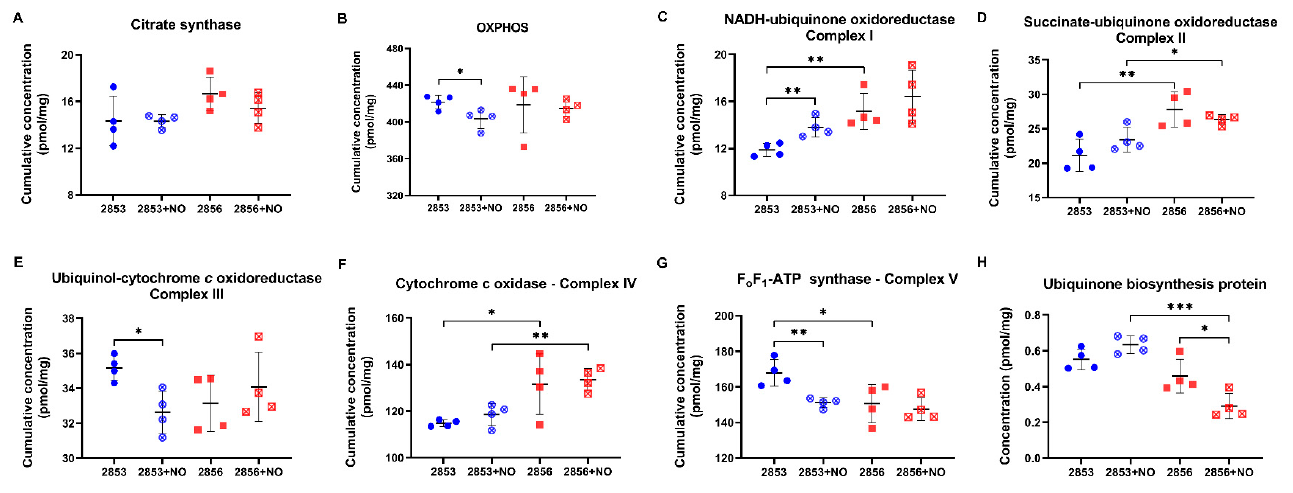
Figure 9. Proteins of mitochondrial oxidative phosphorylation (OXPHOS) are differentially modulated in L. braziliensis strains . ( A ) Cumulative concentration of all the identified proteins as citrate synthase. Cumulative concentration of all the identified proteins involved in ( B ) OXPHOS; ( C ) NADH-ubiquinone oxidoreductase (complex I); ( D ) succinate ubiquinone oxidoreductase (complex II); ( E ) ubiquinol:cytochrome c oxidoreductase (complex III); ( F ) cytochrome c oxidase (complex IV); and ( G ) F o F 1 -ATP synthase (complex V). Each dot represents the total sum of the concentration values of proteins involved in those processes or complexes in each of the four biological replicates. ( H ) Absolute protein concentration of ubiquinone biosynthesis protein. Graphs represent mean ± SD of at least four independent experiments. Statistical differences by Student’s t test (* p < 0.05; ** p < 0.01; and *** p < 0.001). 2853: NO-resistant strain; 2853+NO: NO-resistant strain challenged with 1 / 5 IC 50 /4h NaNO 2 ; 2856: NO-susceptible strain; and 2856+NO: NO-susceptible strain challenged with 1 / 5 IC 50 /4h NaNO 2 .